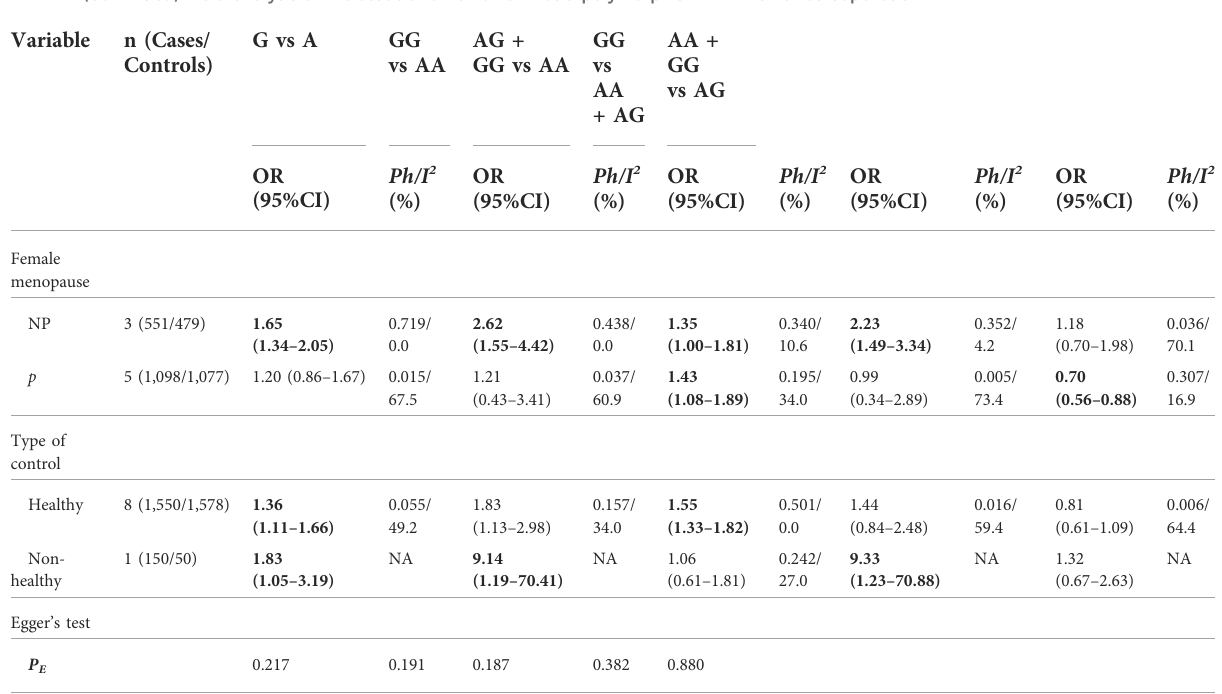
Figure 2) and postmenopausal women (AG + GG vs AA: OR =